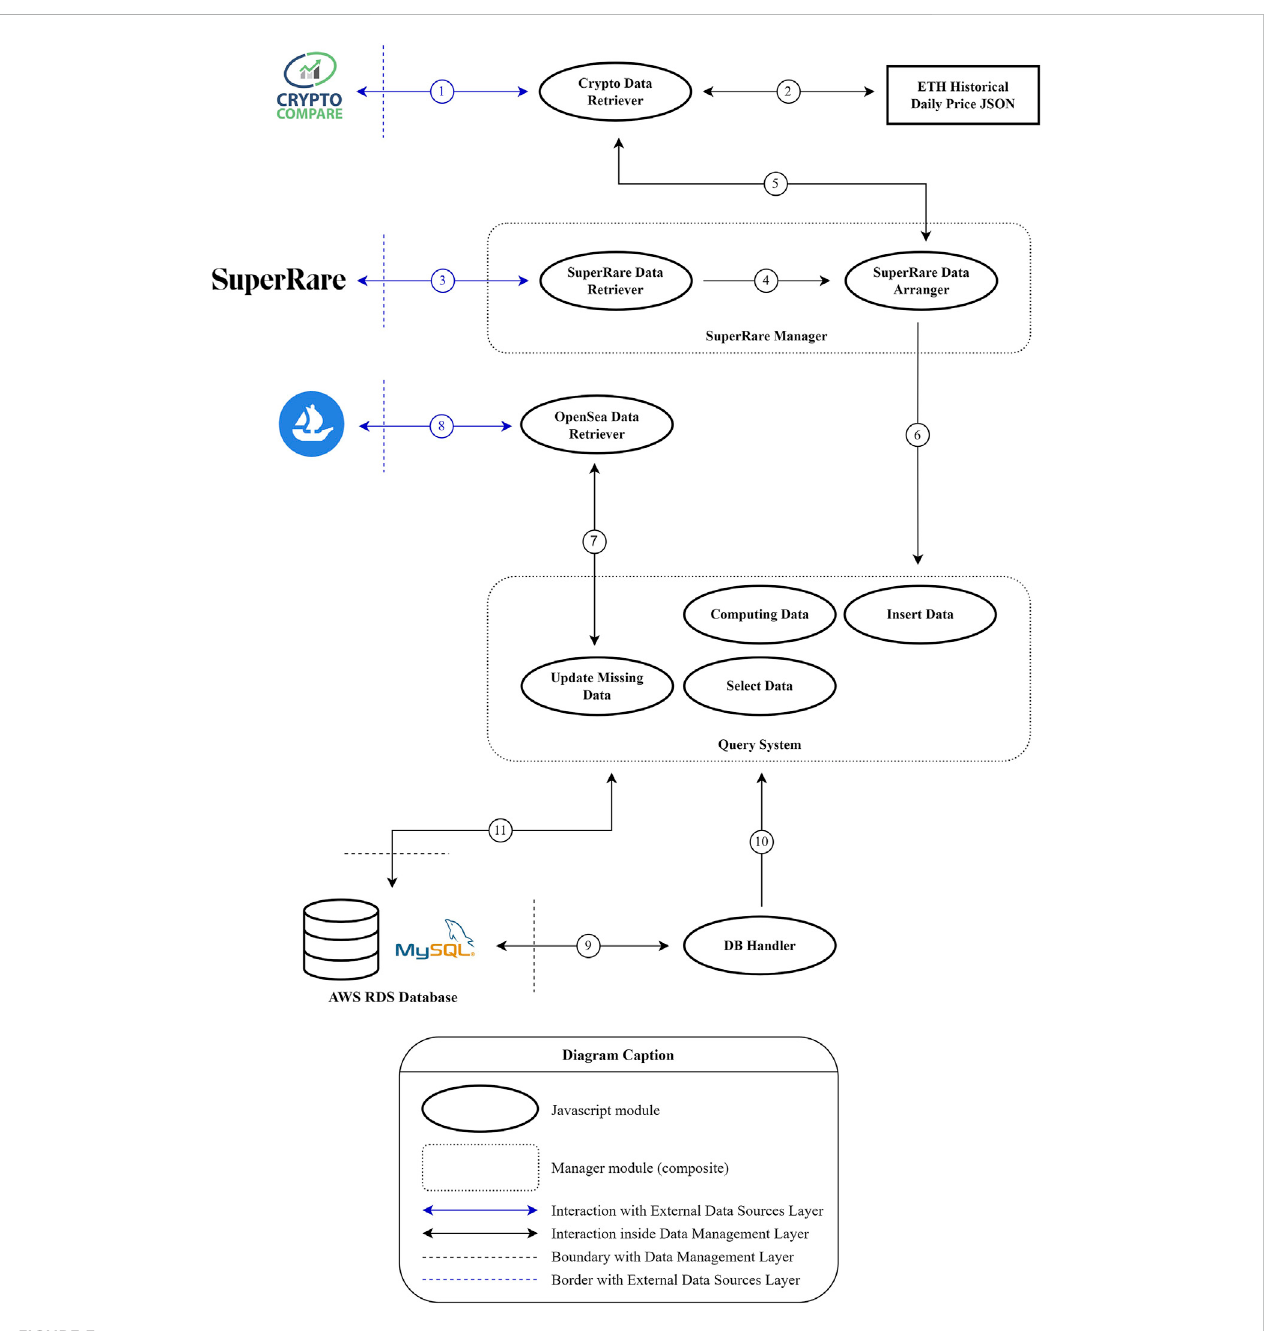
FIGURE 3 Data retrieving infrastructure